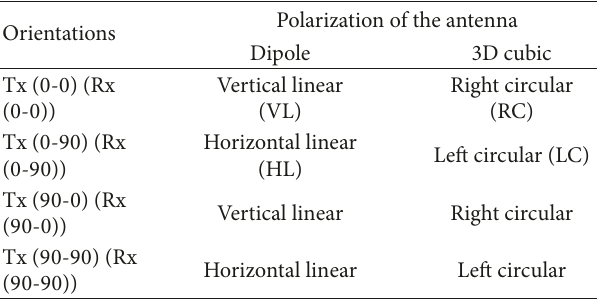
Figure 8: 𝑃𝑟 levels of the same Tx and Rx orientations using the 3D cubic antenna in the LOS scenario. Table 2: The polarization types of each antenna.